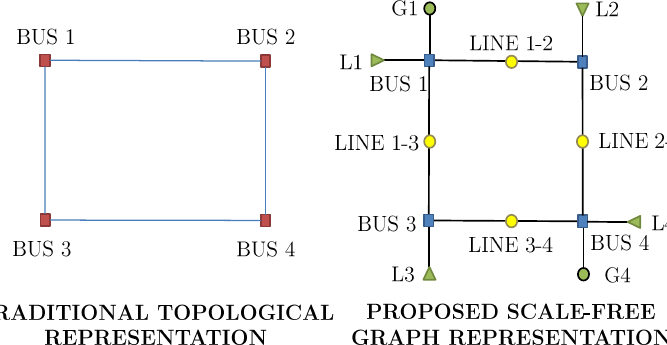
Figure 1. Proposed representation as a scale-free graph of a four-bus electrical